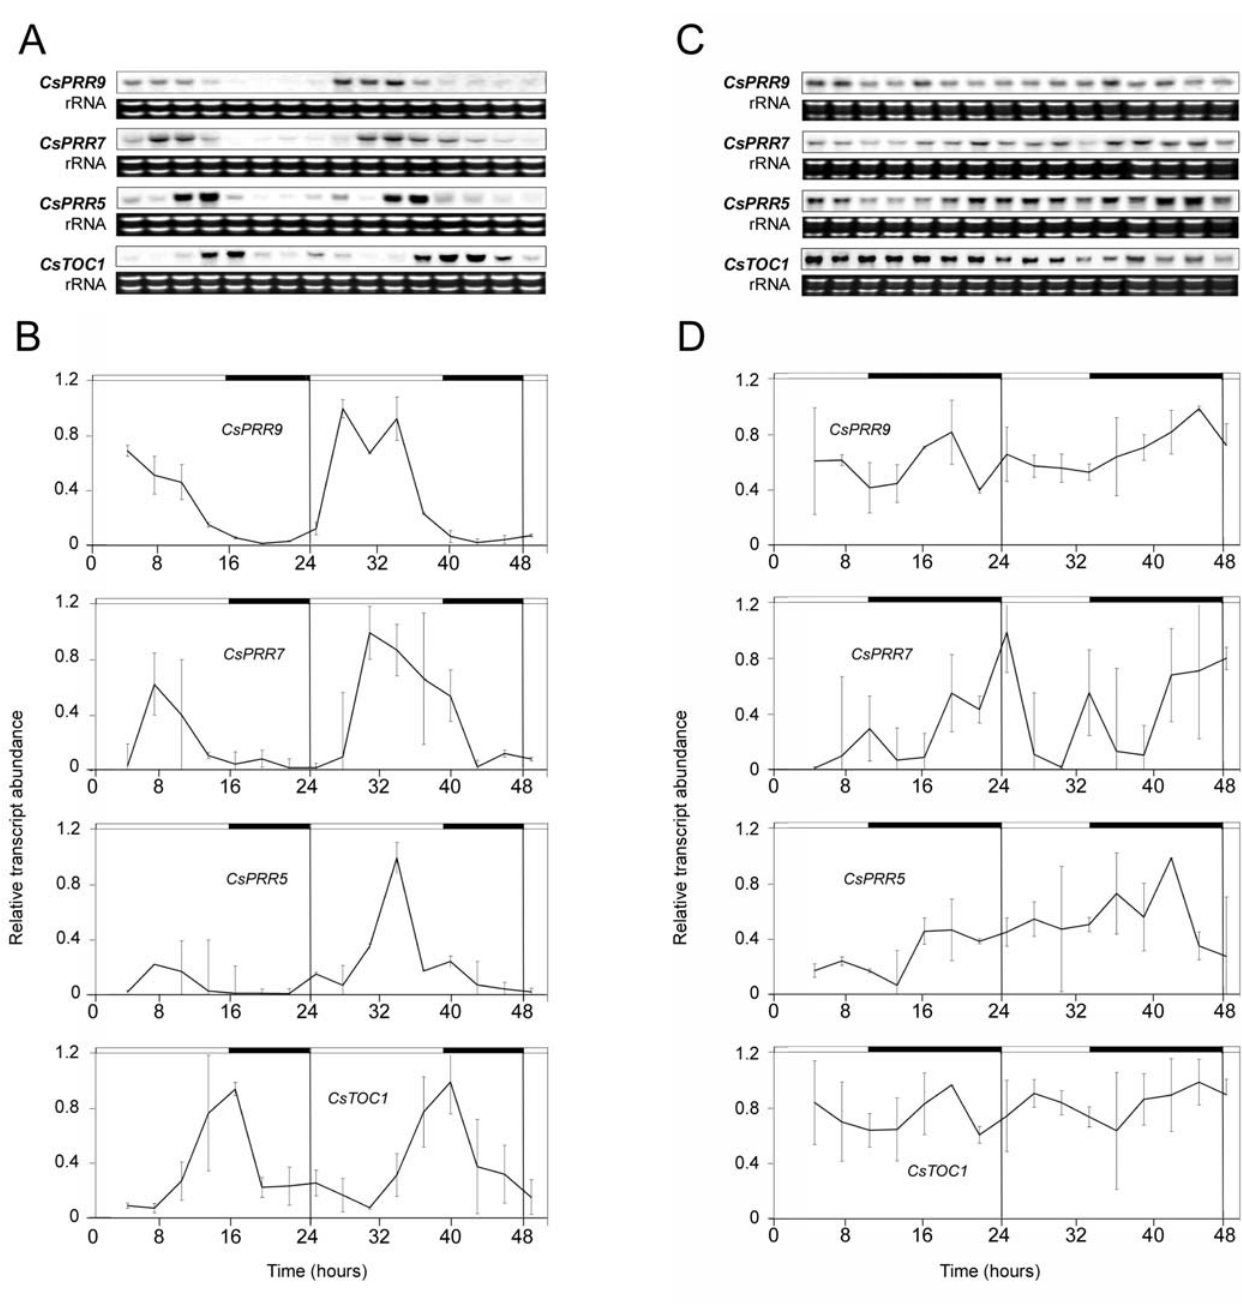
Figure 3. CsPRR gene expression in stems of adult chestnuts under different seasonal conditions. Stems (second-year branch internodes) collected in June ( A and B ) and December ( C and D ). Samples were collected at 3-h intervals. ( A and C ) CsPRR northern blot analysis. The rRNA loading reference was detected by staining gels with ethidium bromide. ( B and D ) Quantitative RT-PCR analysis. Relative transcript abundances are shown in the graphs. Data are means from two biological replicates. Open and filled bars above each graph represent natural day and night lengths, respectively, as provided by the National Institute of Meteorology, Madrid.